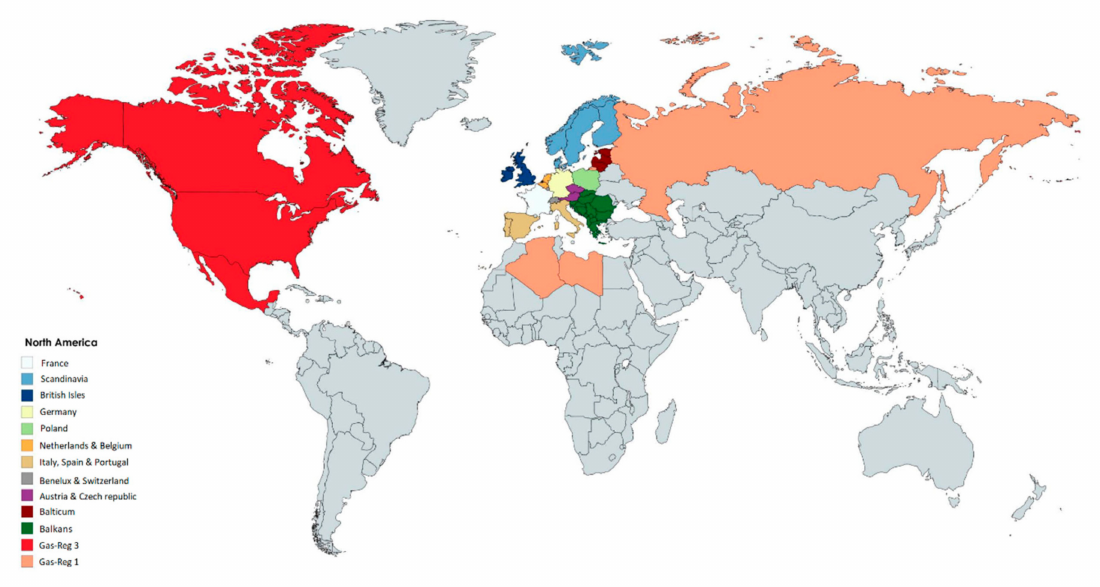
Figure 3. Spatial resolution of the